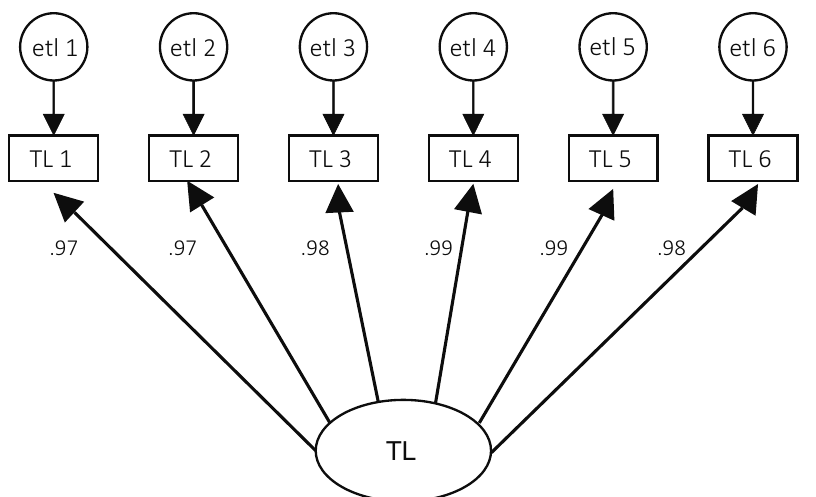
Figure 4. Path diagram of transformational leadership